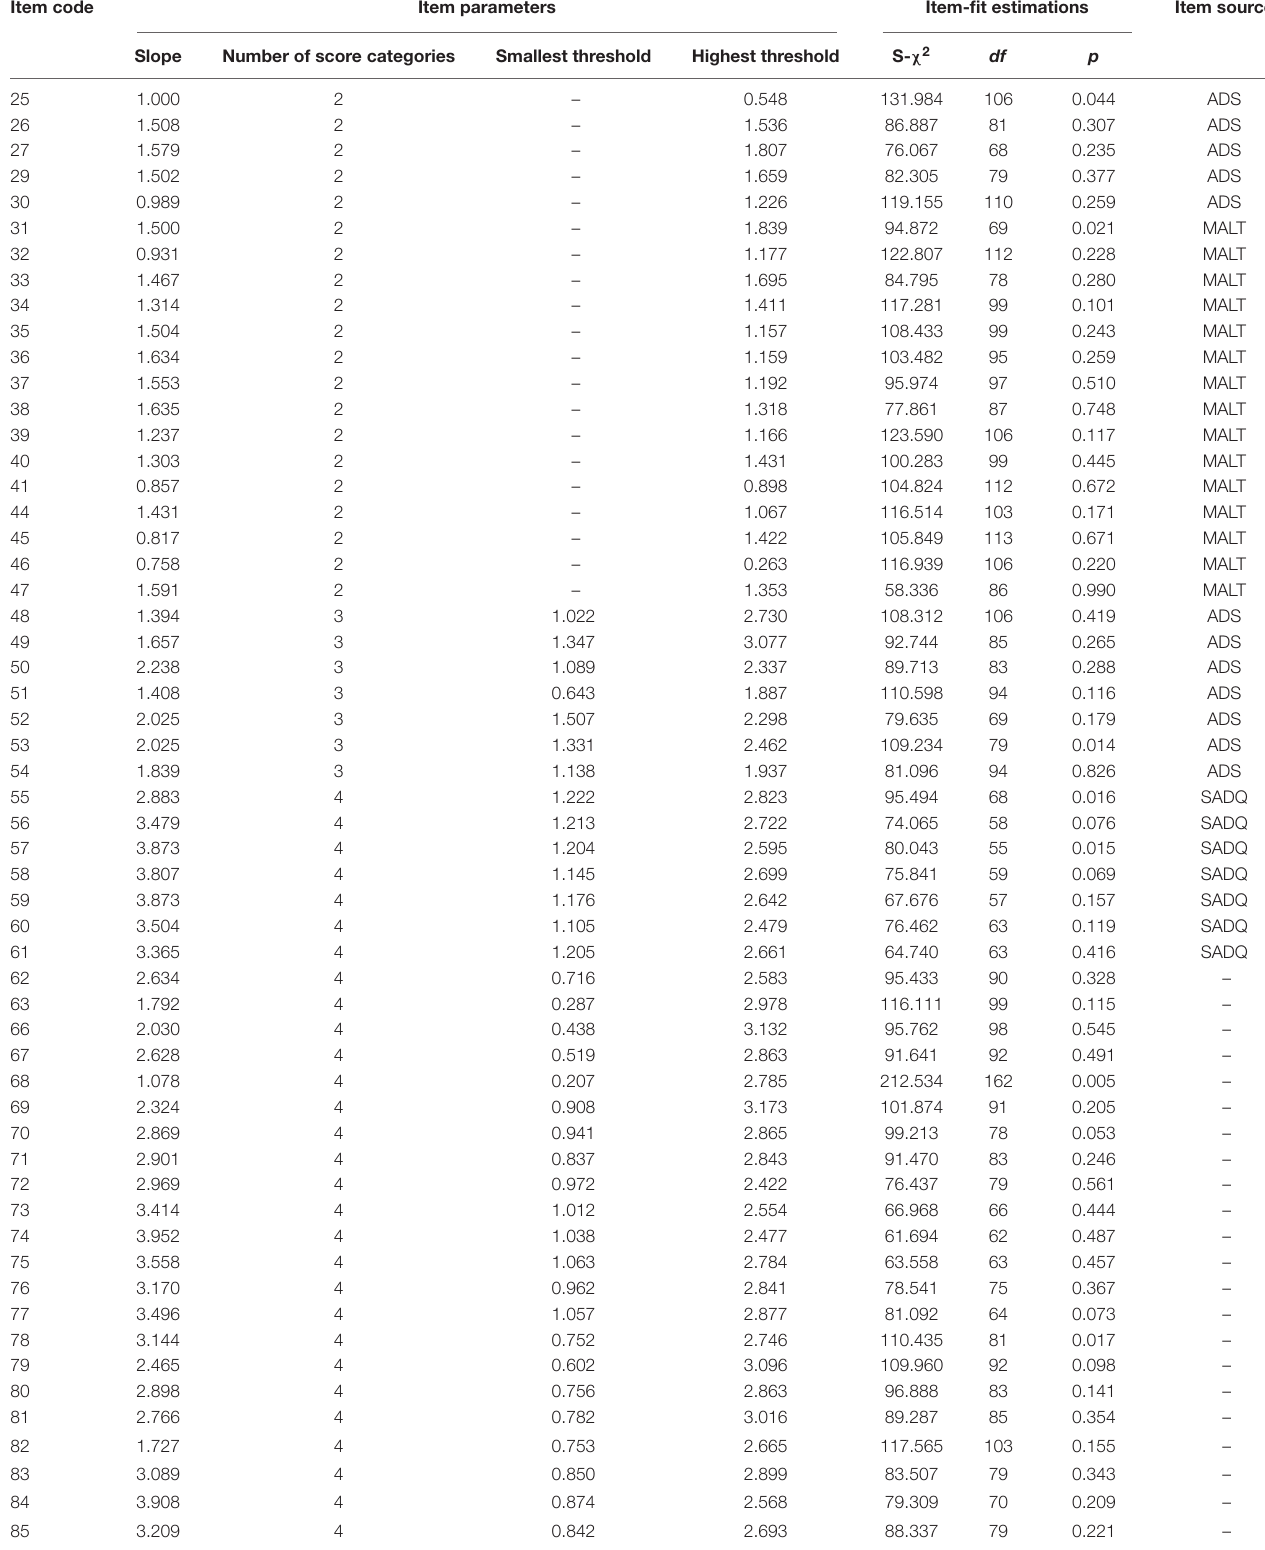
TABLE 2 | Item psychometric information of the final item bank ( n =